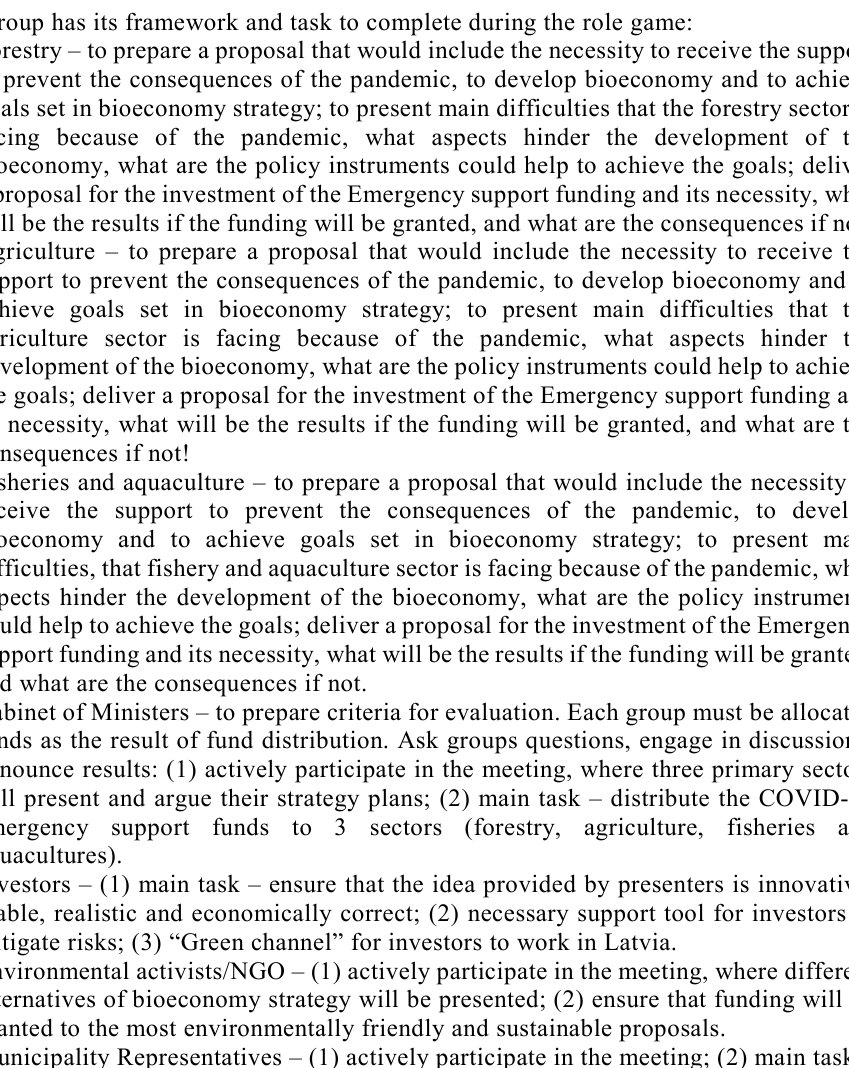
Fig. 2 introduces evaluation criteria for biodiplomacy competence (the authors recommend up to four criteria, as the most relevant and focused criteria for a given competence must be selected from a wide range of possible